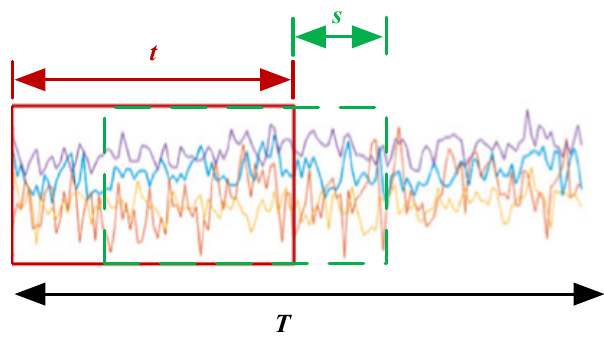
Figure 2. Sliding time window schematic